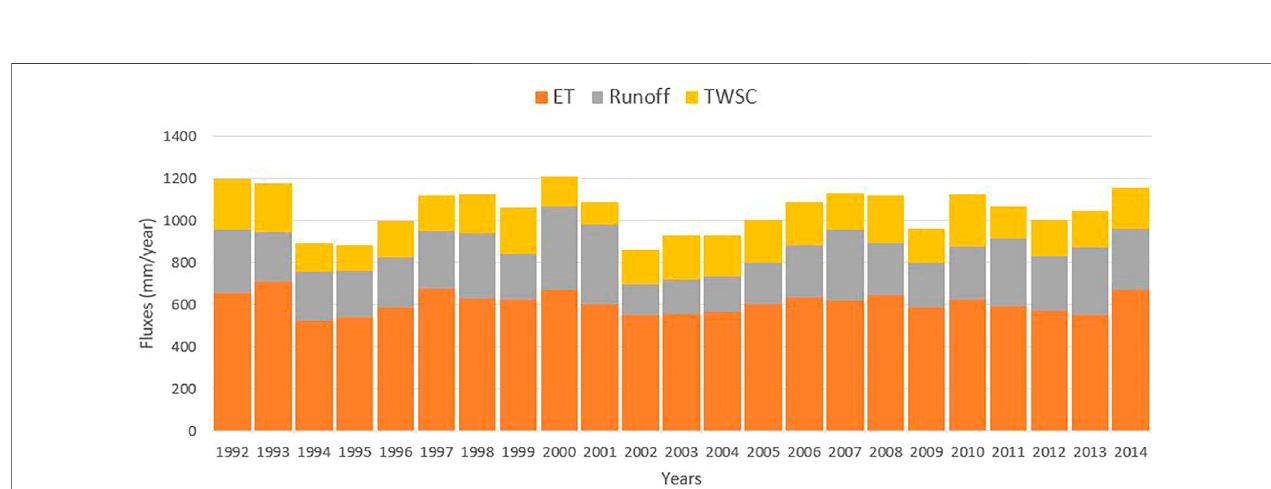
FIGURE11| Water-budget componentsofthebasinand its annual variabilities from1992to2014. Therelative share ofeach ofthe threecomponents(Runoff,ET and TWSC) is shown. The length of the bars represents total precipitation.